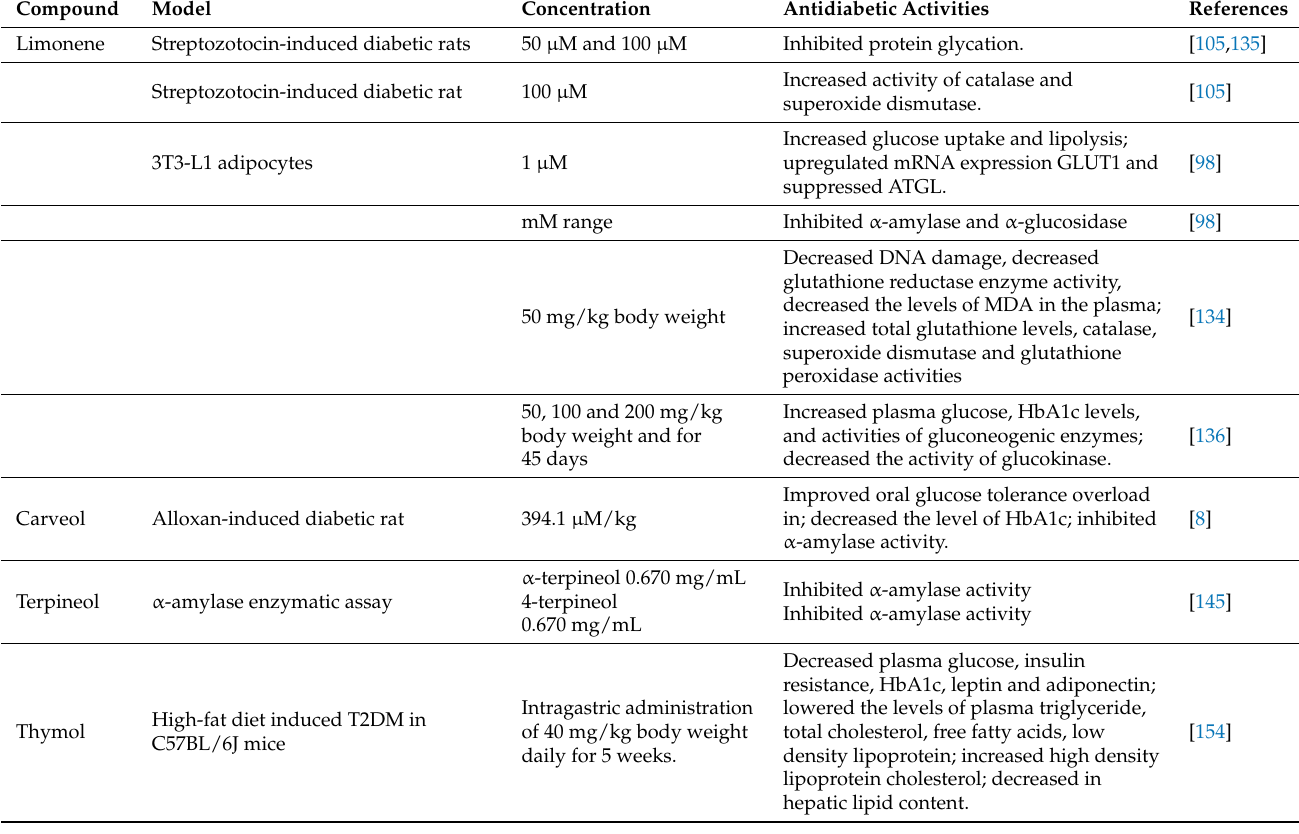
Table 2. Antidiabetic effects of monocyclic